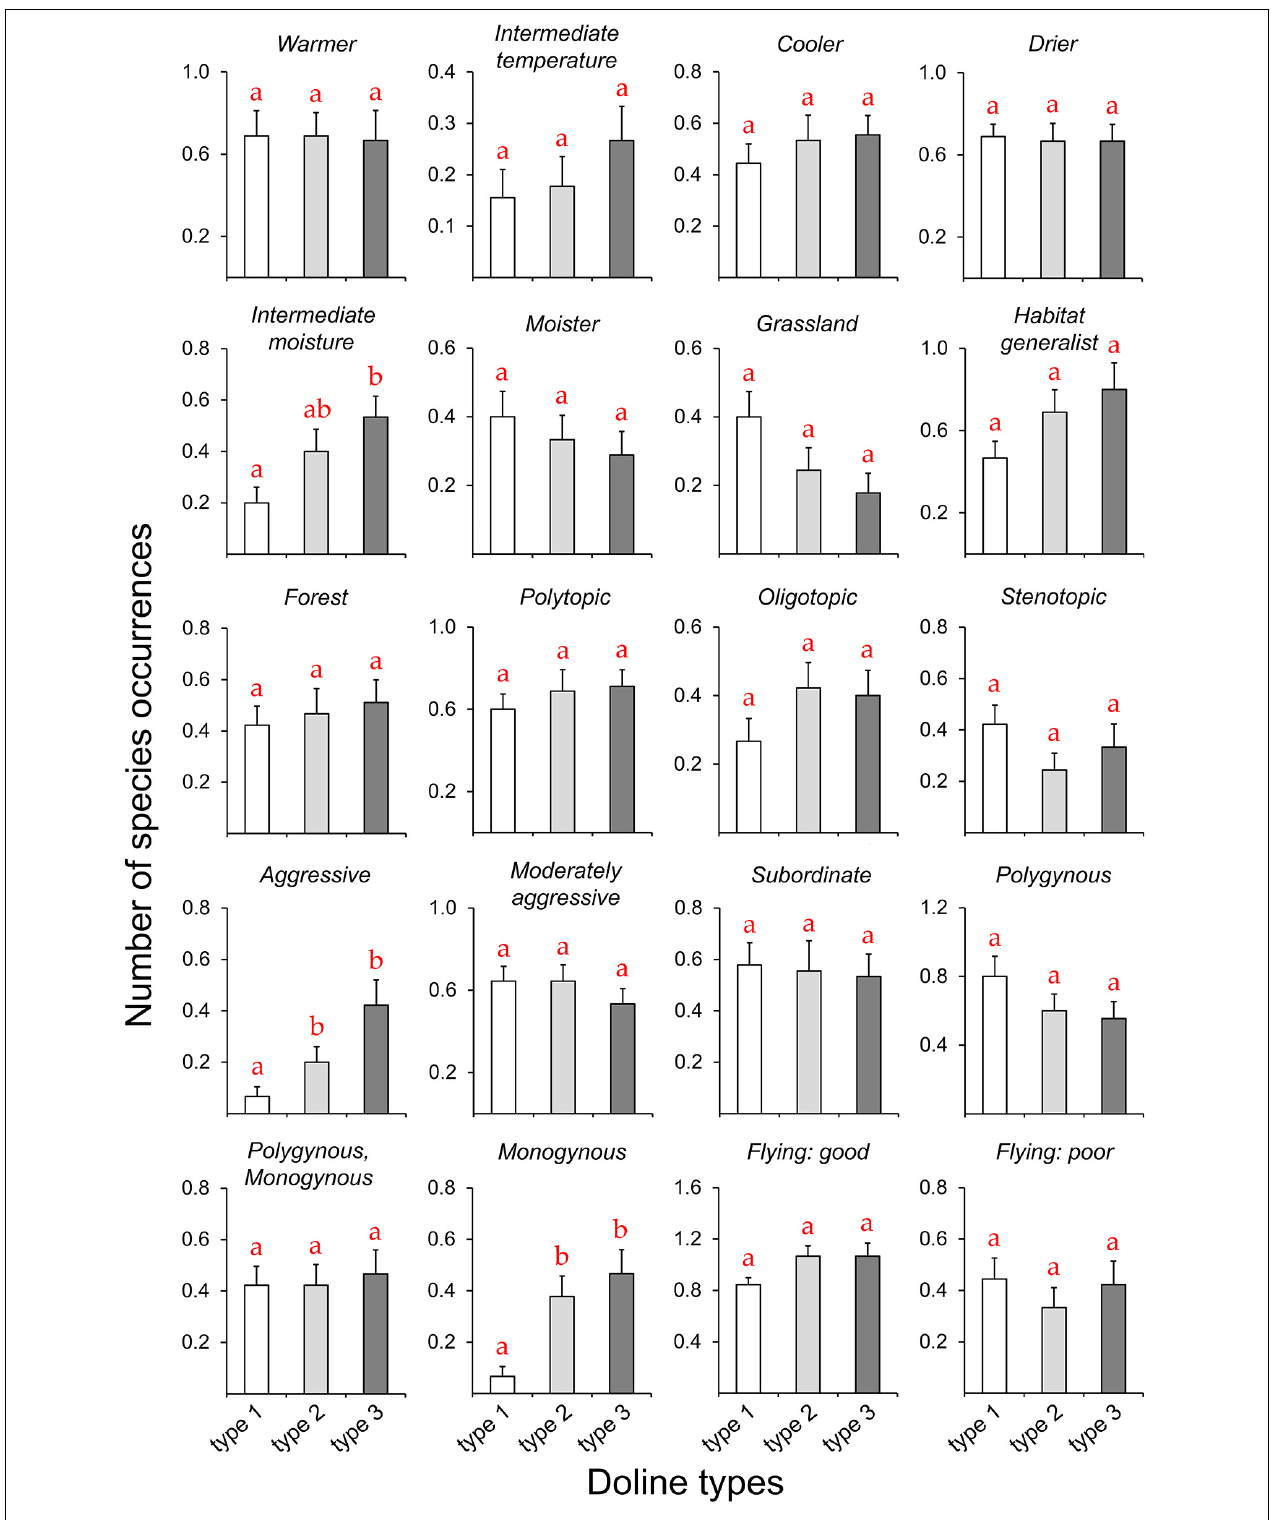
FIGURE 3 | Occurrences of the different functional groups and traits (see Table 1 ) of ant species (mean ± SE) among the different doline types (types 1–3). Different lowercase letters indicate significant differences between the types (see Table 3 and Supplementary Table 3 ).